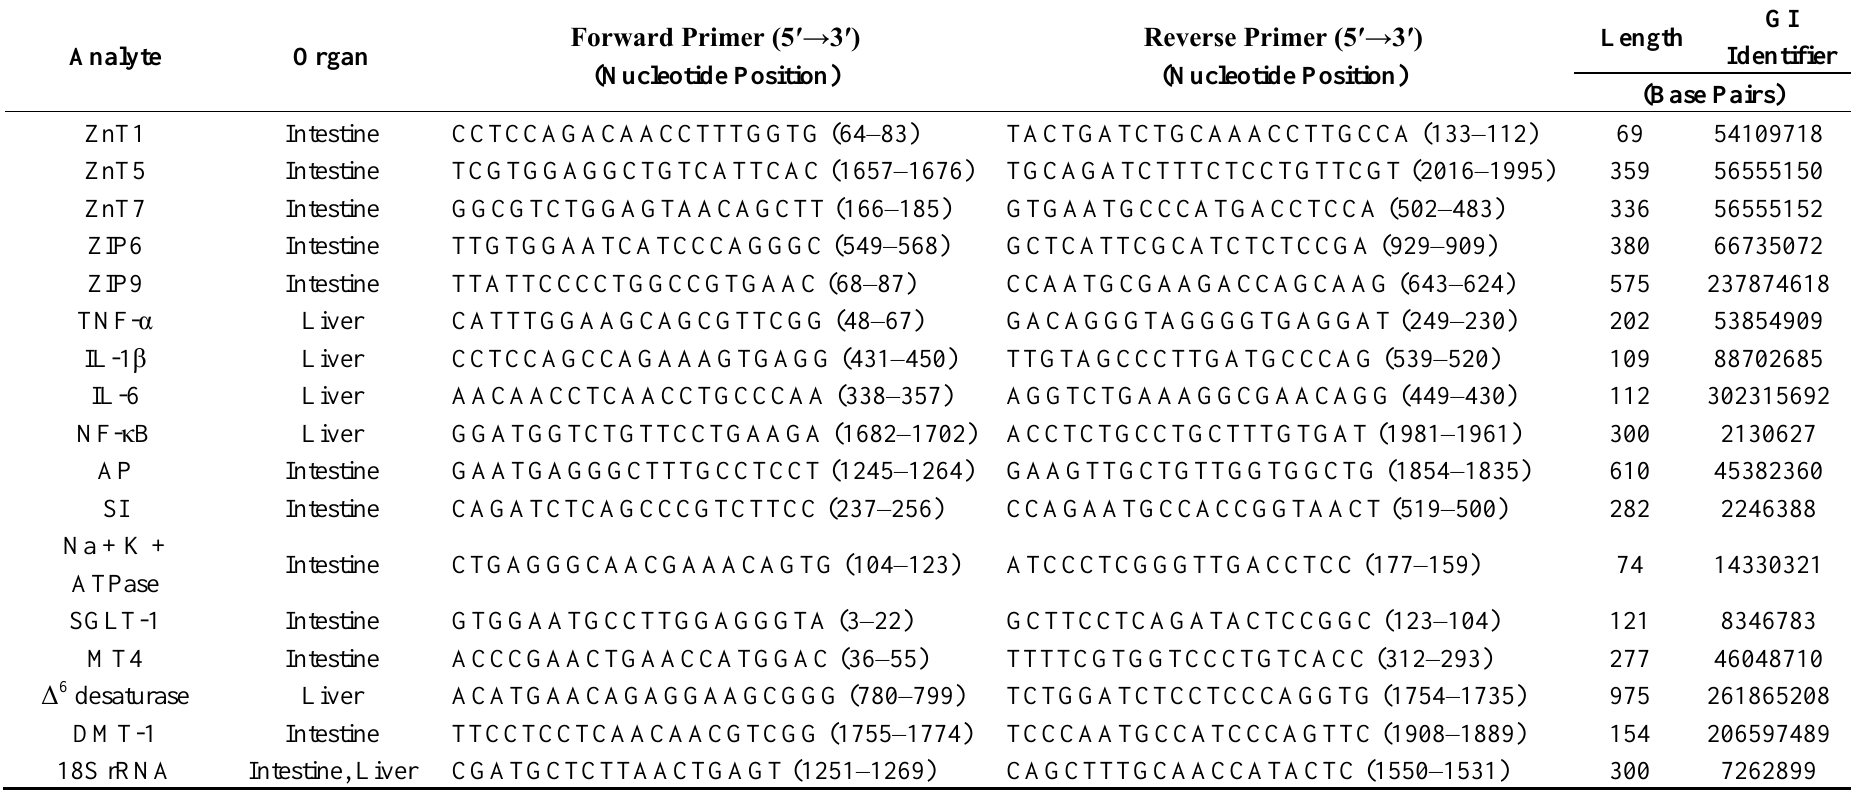
Table 3. Measured genes ( Gallus gallus ) and tissue-specific 18S rRNA from